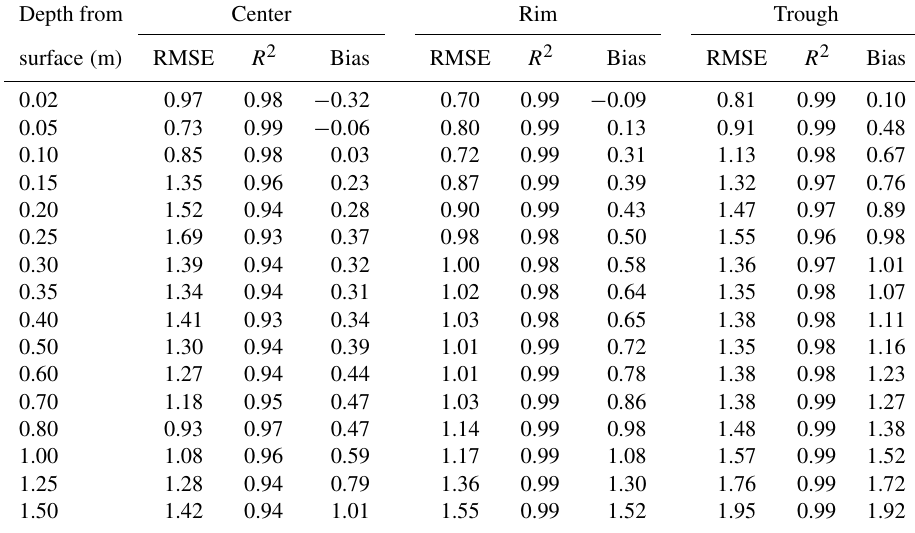
Table E1. Model performance statistics at Site A compared to observed soil temperatures. Depth from Center Rim Trough surface ( m )